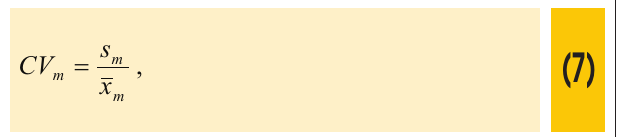
In addition to the correlation curve, the results obtained in the tests carried out on the plates were used to verify the second coefficient of variation of the assay. To do so, the coefficient of variation of the results of each of the plates for different ages and the average coefficient of variation CV were calculated using equation (7).